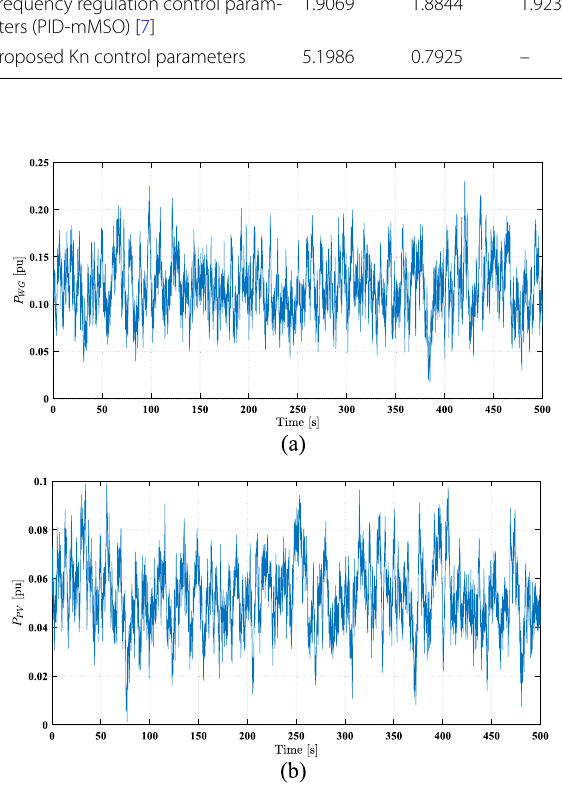
Fig. 5 The power profile of a wind generator and b PV system